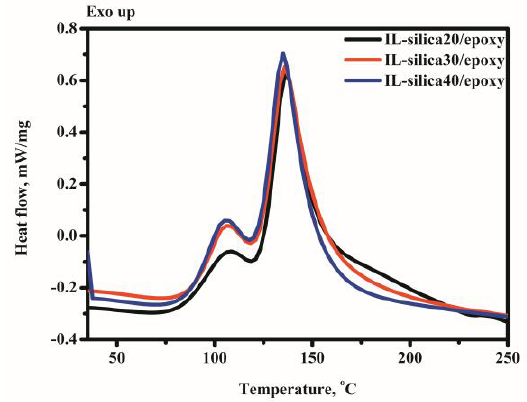
Figure 3. Differential scanning calorimetry (DSC) curves of epoxy composites with 20, 30, and 40 phr IL-silica heated at 5 °C/min.